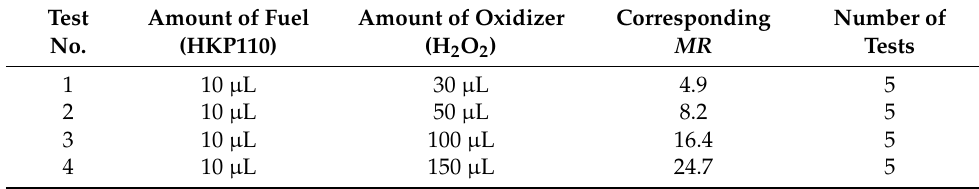
Table 2. Test conditions of drop